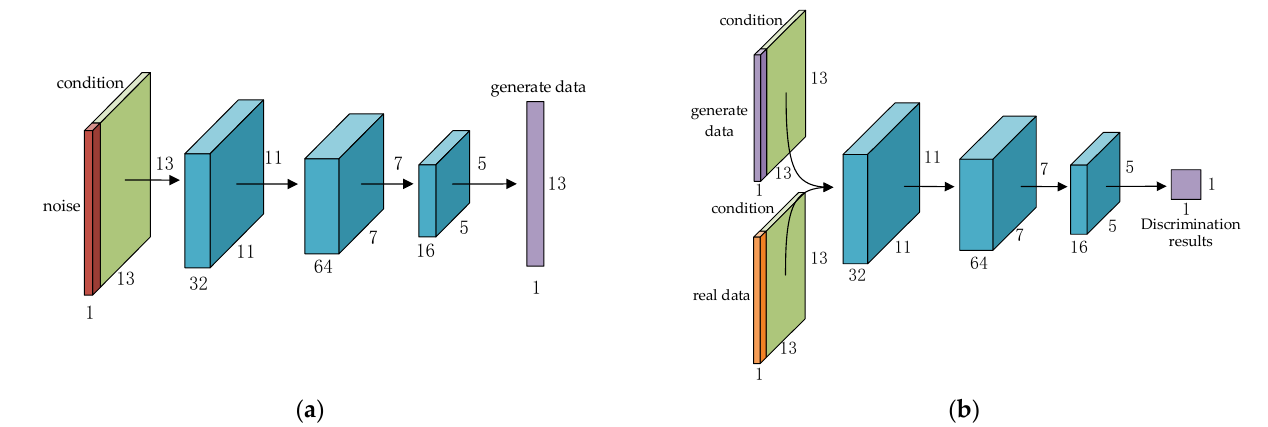
Figure 2. CGAN structure design: ( a ) Generator network structure; ( b ) Discriminator network structure. Table 1. Generator network